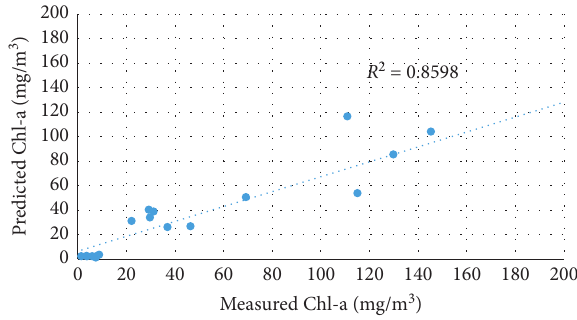
Figure 12: Regression between predicted and measured Chl-a using the B3/B2